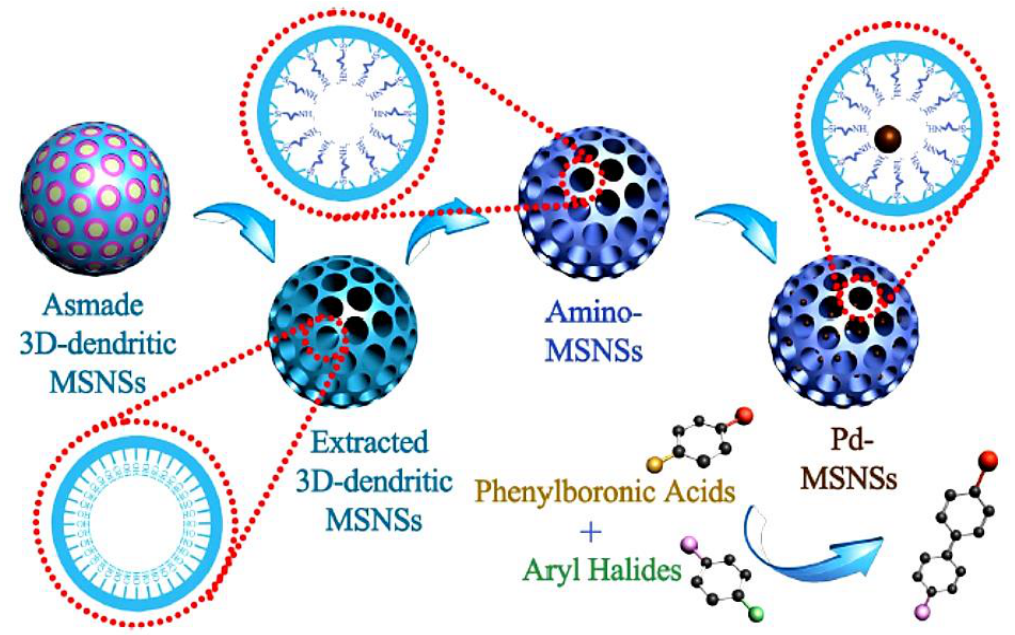
Figure 3. Synthesis and catalytic process of highly monodispersed palladium nanoparticles immobilized in three- dimensional dendritic mesoporous silica. Reproduced with permission from in [99].